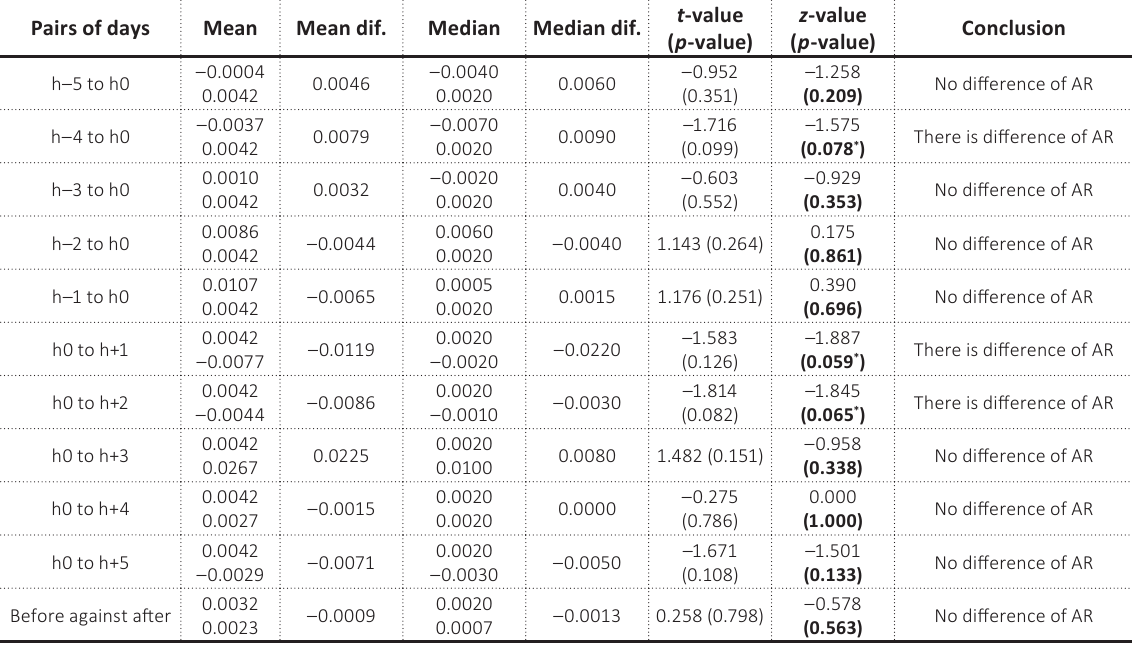
Table 6. Summary of second hypothesis testing results Pairs of